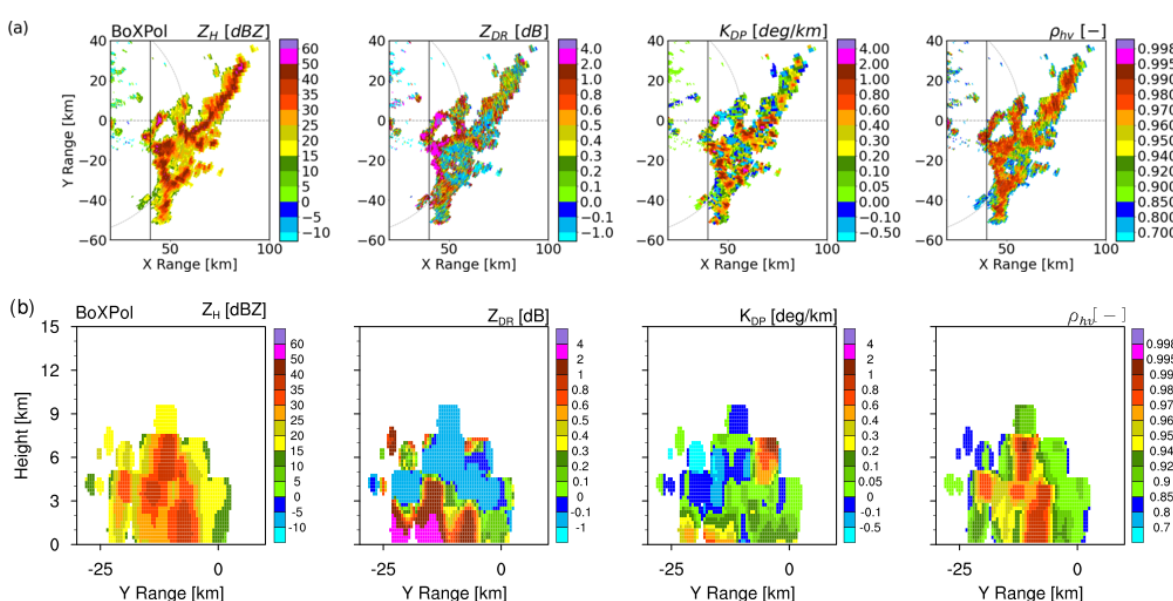
Figure 7. (a) PPI plots of horizontal reflectivity, differential reflectivity, specific differential phase and cross-correlation coefficient at 1.0 ◦ elevation measured by BoXPol on 13 May 2016 at 10:30UTC. The dotted grey circles represent slant ranges for the chosen elevation angle, associated with height of 1km (lower levels). (b) Cross section of the same polarimetric variables from the gridded data. The vertical solid black line along the Y range in panel (a) indicates the location of cross-section